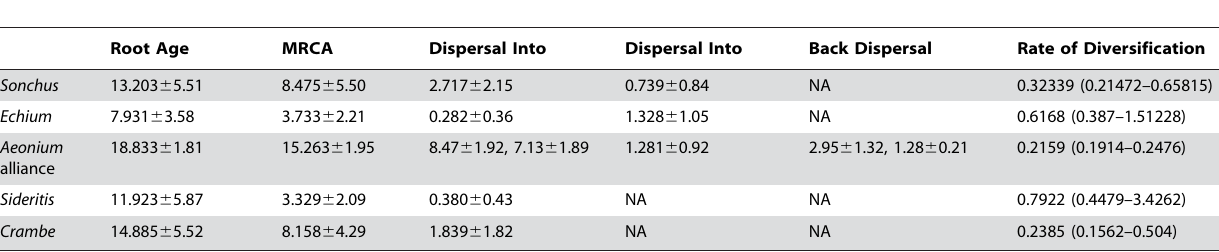
Table 1. Absolute age estimates of MRCA (most recent common ancestor) in the Macaronesian Islands, colonization events into other archipelagos (i.e., Madeira and Cape Verde), and back dispersal to mainland Africa (21 My hard bound analyses based on the oldest age of the Canary archipelago are in